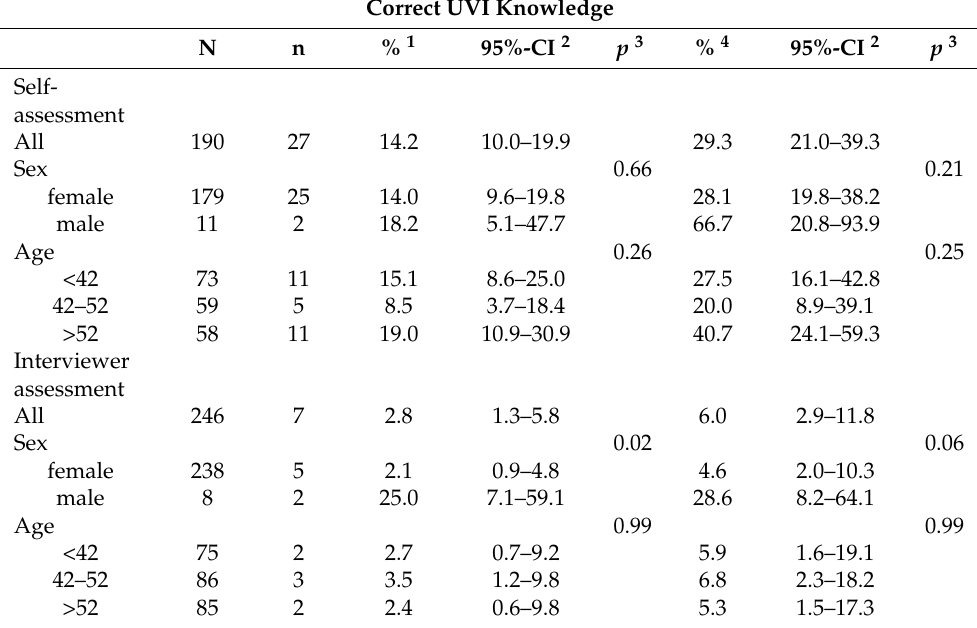
Table 3. Self-assessed and interviewer-assessed level of knowledge about the UVI among directors of kindergartens (N = 436). Absolute frequencies (N = sample size; n = number with correct knowl- edge), proportions (%) accompanied by confidence intervals (95%-CI) and p -values ( p ) comparing proportions between